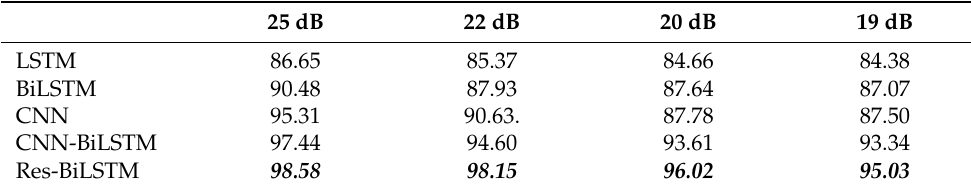
Table 4. Accuracy comparison of different algorithms under different